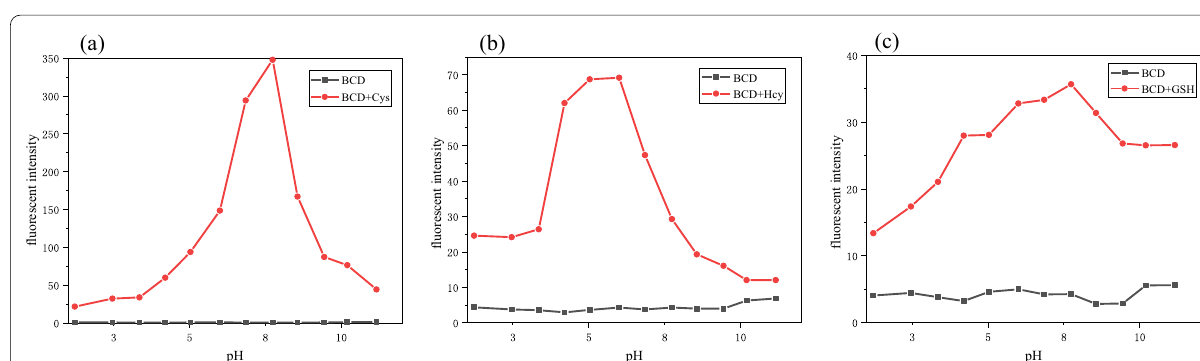
Fig. 6 a Fluorescent intensity at 502 nm of BCD (60 μM) at various pH values in DMF-Hepes buffer (8/2, v/v, pH 7.4) medium in the absence = and presence of Cys (1 mM), λex 463 nm. b Fluorescent intensity at 479 nm of BCD (60 μM) at various pH values in DMF-Hepes buffer (8/2, v/v, = pH 7.4) medium in the absence and presence of Hcy (1 mM), λex 396 nm. c Fluorescent intensity at 476 nm of BCD (60 μM) at various pH values = = in DMF-Hepes buffer (8/2, v/v, pH 7.4) medium in the absence and presence of GSH (1 mM), λex 365 = =